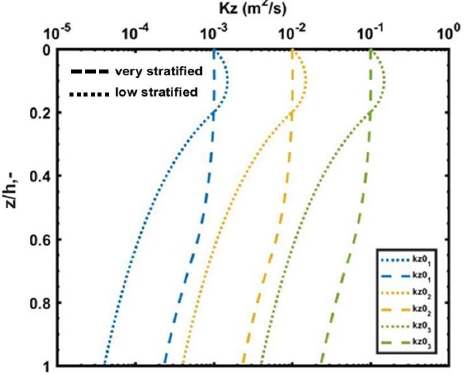
Figure 4. Profile variations for turbulent viscosity with depth. Very stratified column water (consecutive dots) and low stratified column water (dashed lines).